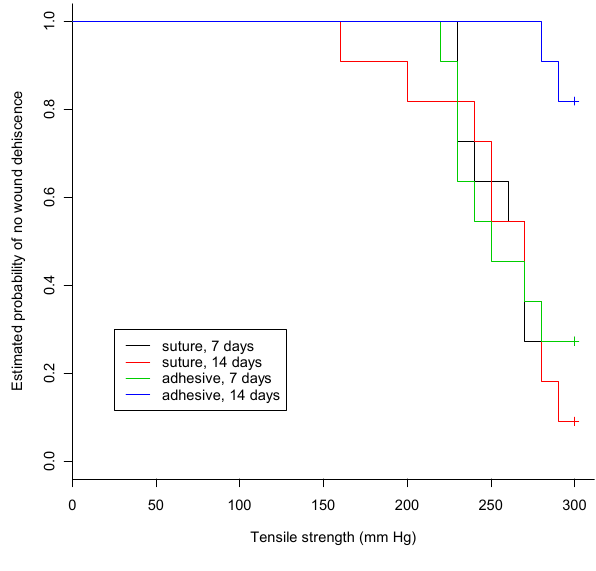
FIGURE 5 – Kaplan-Meier survival curves